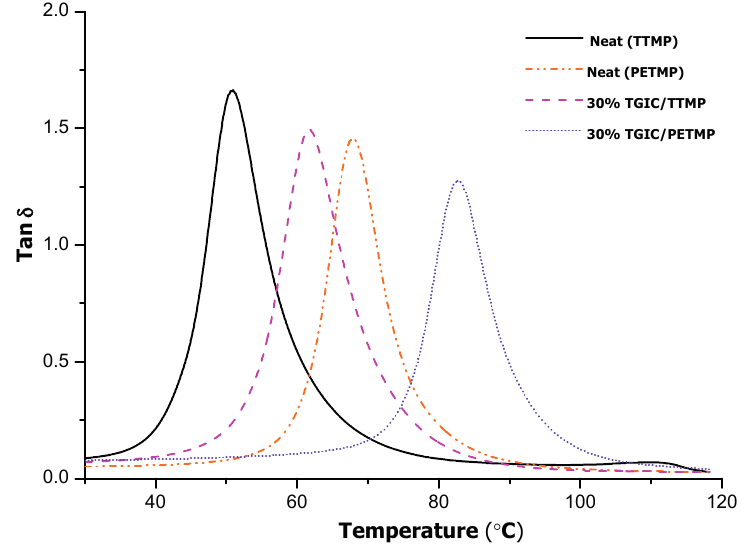
Figure 9. Plots of tan δ against temperature for the thermosets obtained by using TTMP and PETMP as curing